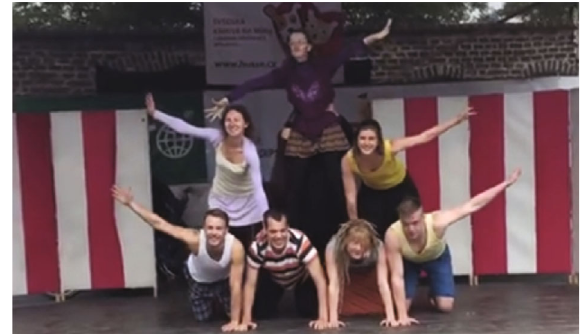
Figure 1: Performers show o ff and receive applause for their performance